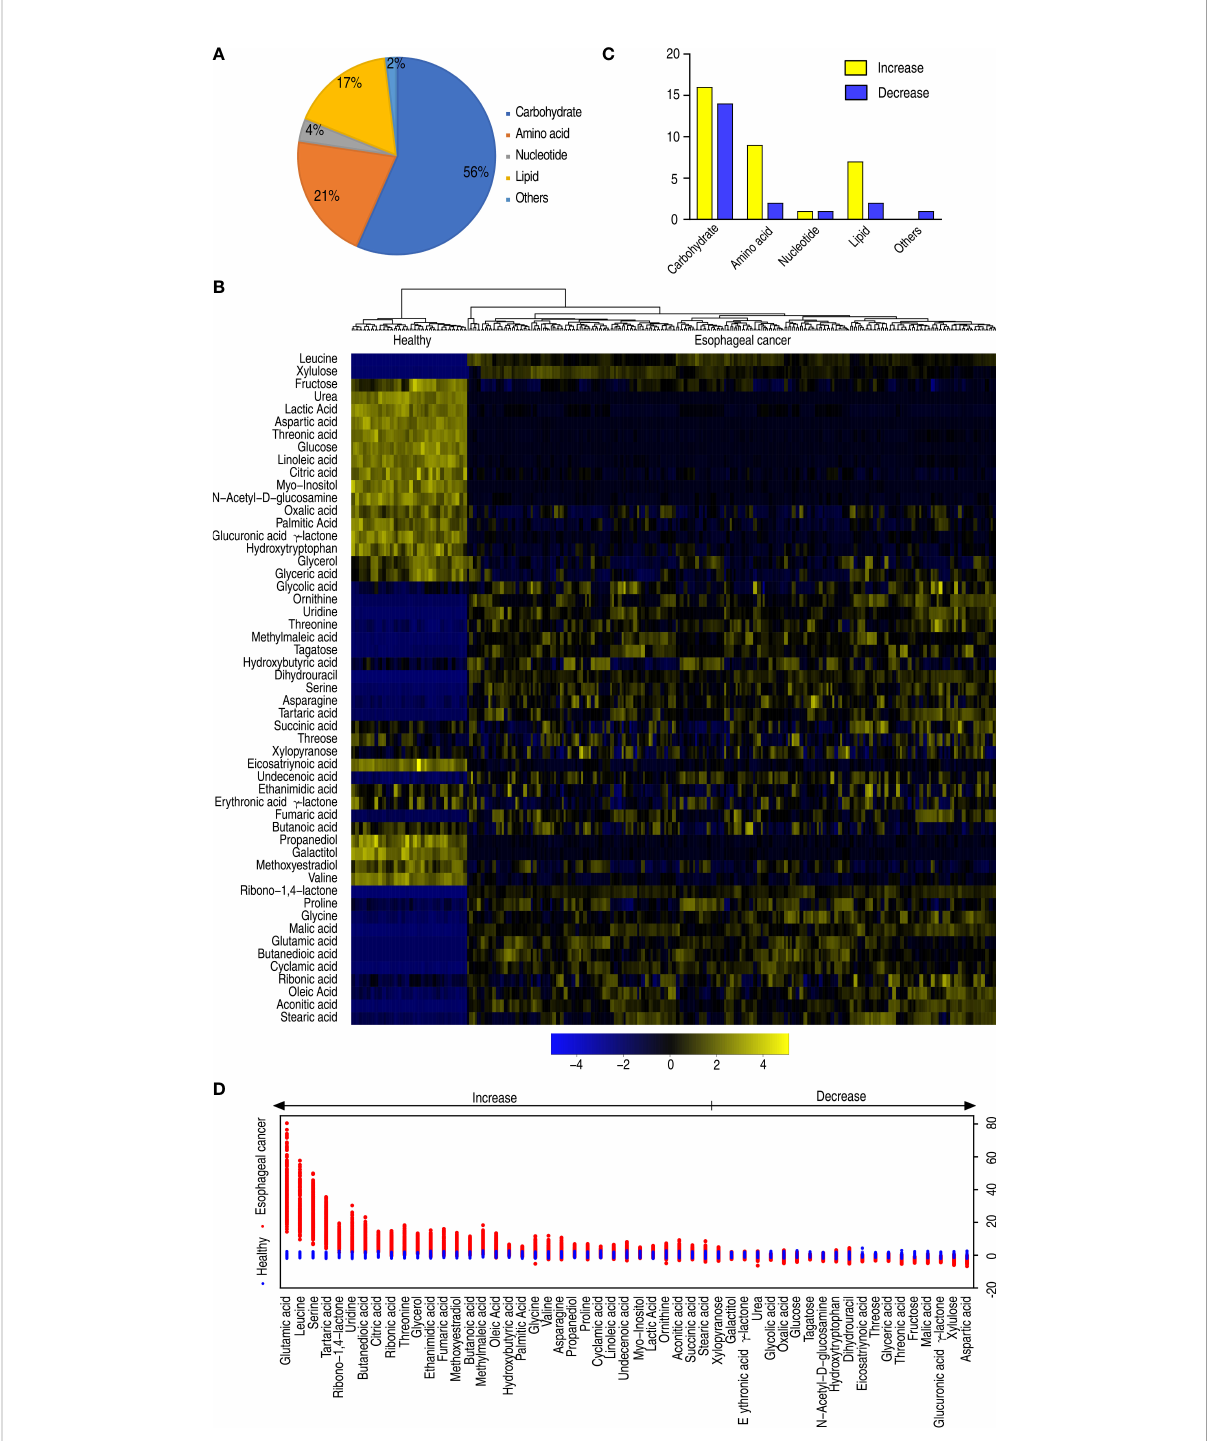
FIGURE 2 Differential metabolomes of patients with esophageal cancer. (A) Categories of the differential abundance of metabolites. (B) Heatmap showing differential abundance of metabolites. Yellow color and blue color indicate increase and decrease of metabolites relative to the median metabolite level, respectively (see color scale). (C) The number of differentially abundant metabolites is increased and decreased in every category. (D) Z -score plot of differential metabolites based on control (health). The data of the esophageal cancer group are scaled to the mean and standard deviation of control. Each point represents one metabolite in one technical repeat and is colored by sample